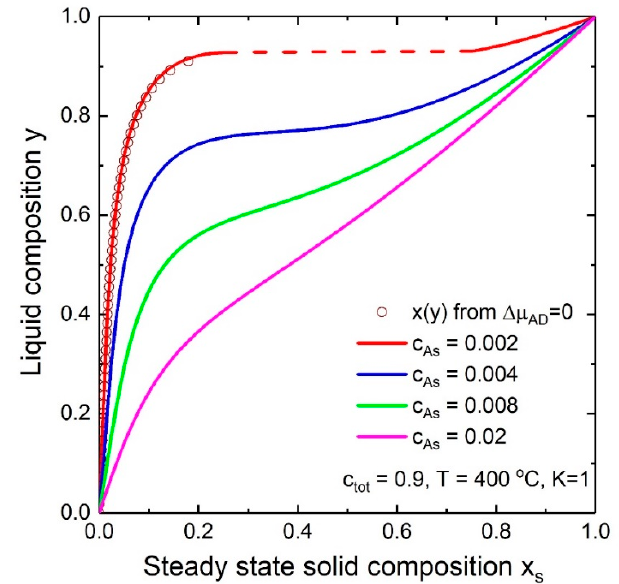
Figure 3. Dependence of the steady-state solid composition on the liquid composition for In x Ga 1 − x As NWs. Solid lines and circles correspond to Equations (8) and (20), respectively. Dashed line indicates miscibility gap.